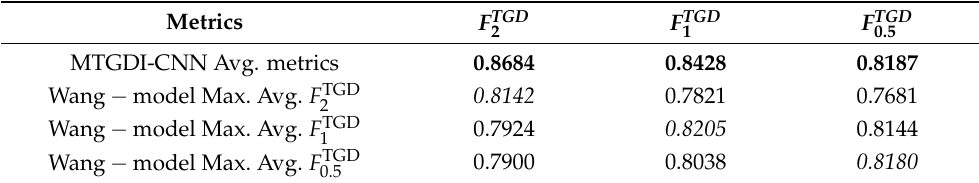
Table 6. Comparison of model performance evaluation results with those of black-box acquired